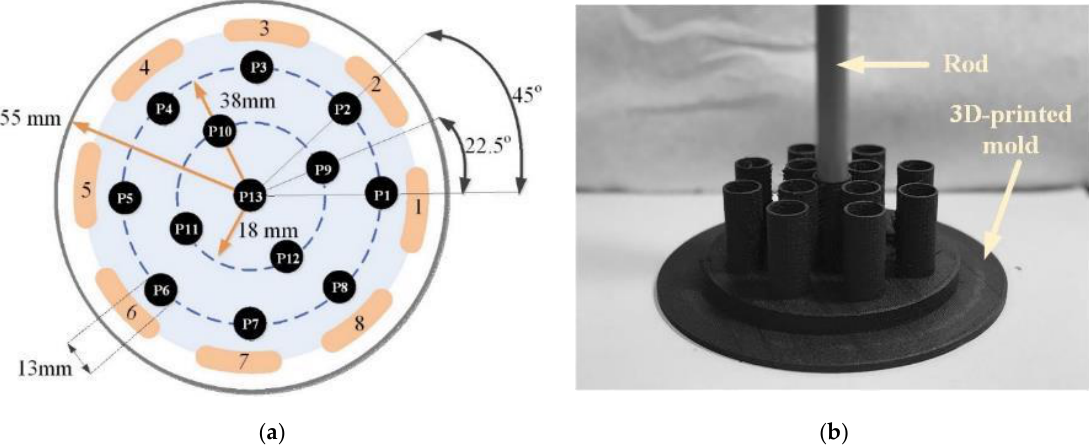
Figure 2. ( a ) To characterize ECT permittivity imaging accuracy, a 13 mm-diameter polyvinyl chloride (PVC) rod was placed at 13 different locations in the ECT electrode array. Their positions were marked as P1, P2, P3, . . . , and P13. ( b ) A 3D-printed mold was prepared and employed to accurately maintain the locations of the rod, and the mold was fitted below the ECT electrode array.